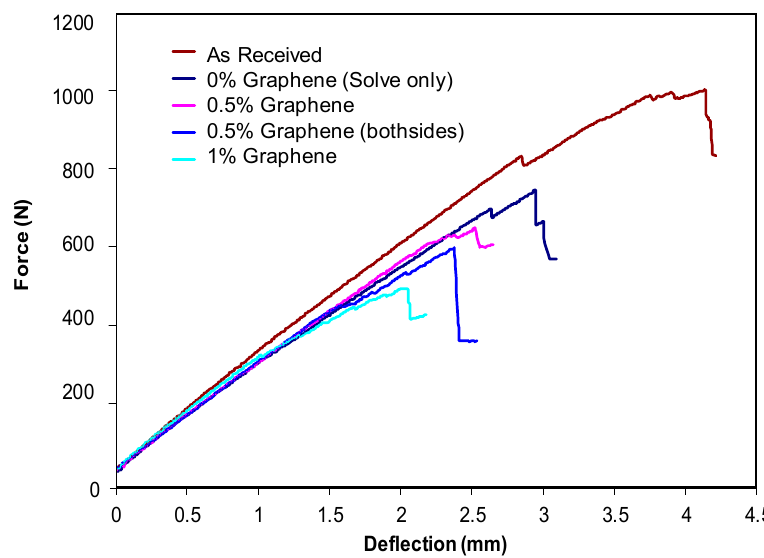
Figure 11. Load vs. deflection curves for different percentages of graphene coated glass fiber composites. The plots in Figure 12a show the average flexural modulus and average flexural strength with error bars representing the range of the data for each set of experiments. The flexural modulus was highest with the 1% graphene amount while it remained almost constant for all other samples. The flexural strength decreased as the amount of graphene increased as shown in Figure 12b. The graphene used in this study was not functionalized, and it is anticipated that after treatment with resin compatible functional groups, the static and dynamic properties can be enhanced [12].